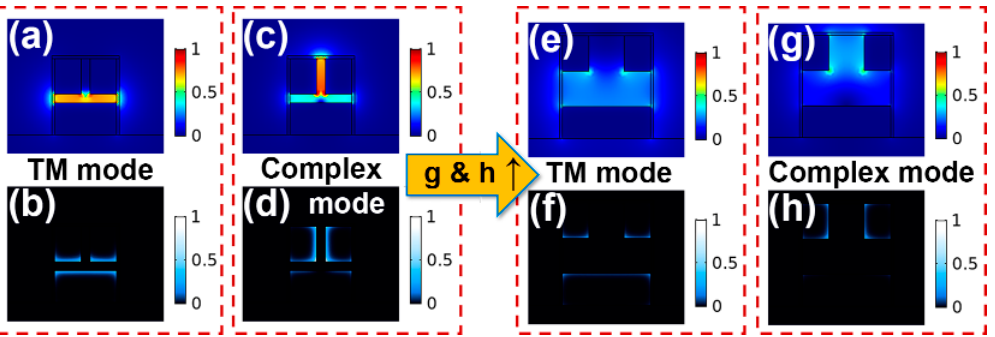
Figure 5. Comparison of normalized electric field distributions and ohmic loss profiles under different waveguide dimen- sions. When h and g are 50 nm, ( a , b ) are electric field distribution and ohmic loss profile for the TM mode, respectively; ( c , d ) are corresponding cases for the complex mode. When h and g are 200 nm; ( e , f ) are electric field distribution and ohmic loss profile for the TM mode, respectively; ( g , h ) are corresponding cases for the complex mode.